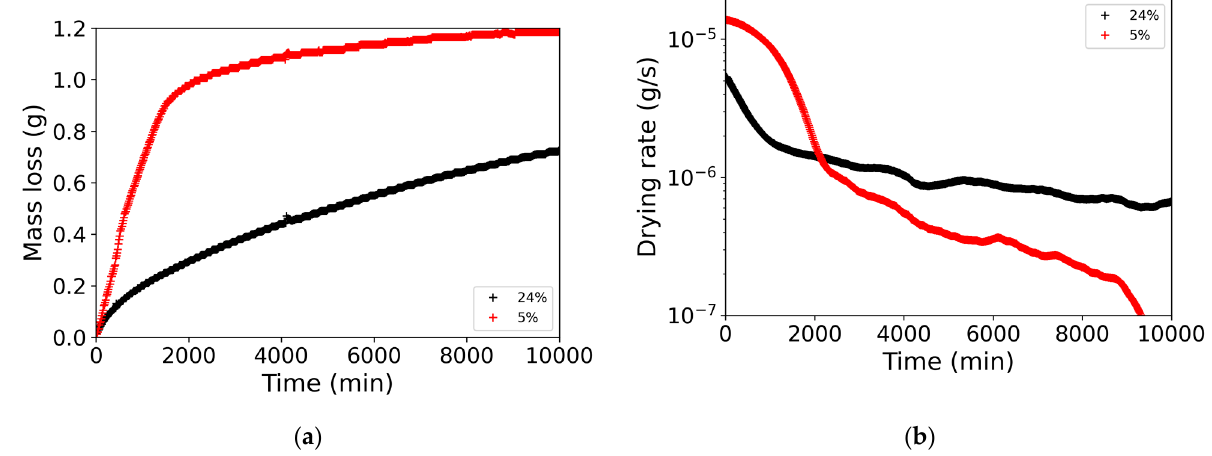
Figure 2. ( a ) Mass loss as a function of time; ( b ) drying rate as a function of time. Black symbols: initial particle volume fraction 𝜑 = 24% ; red symbols: initial particle volume fraction 𝜑 = 5% .